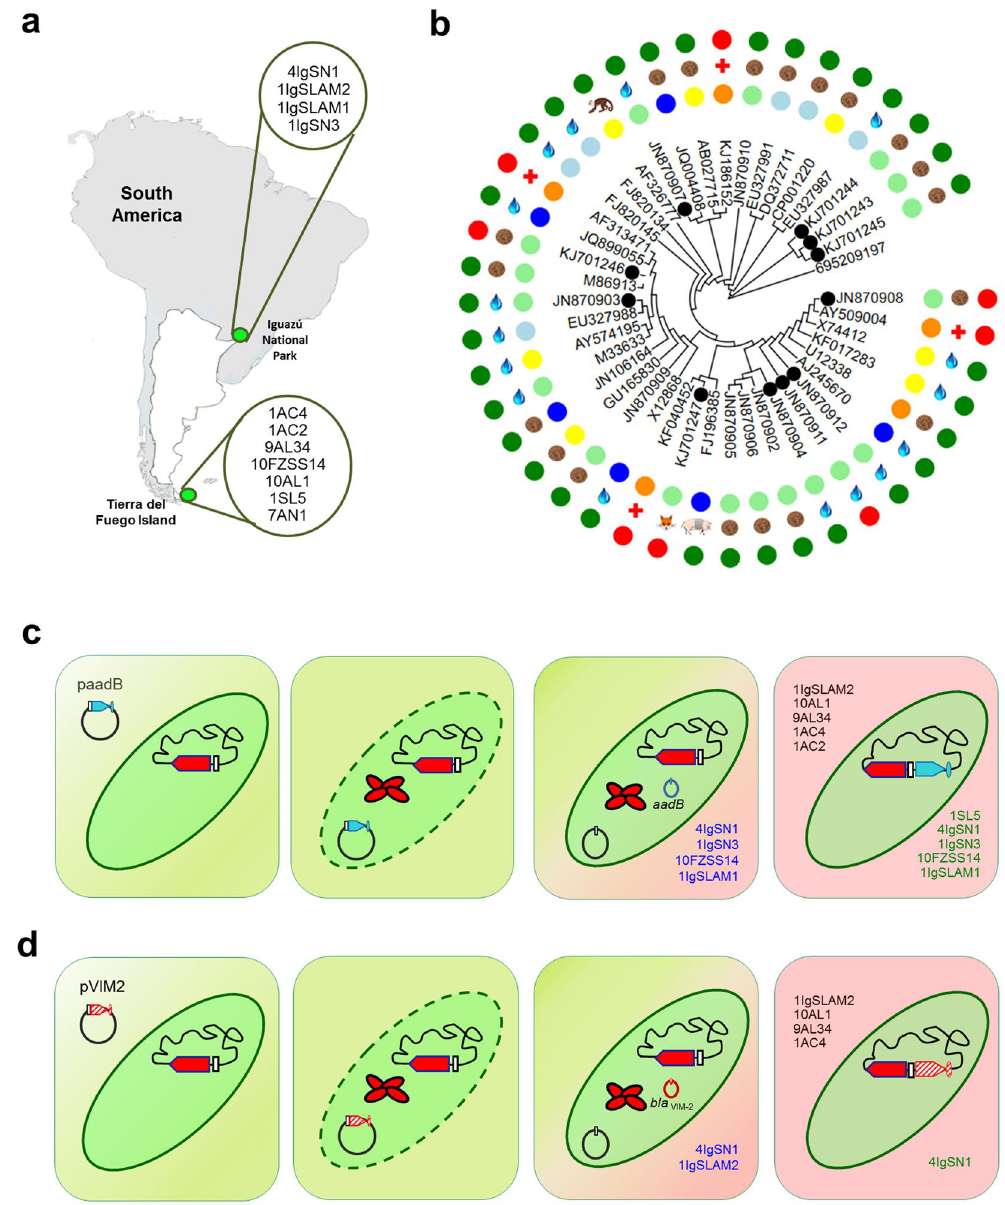
Figure 2. Model system of environmental intI1 -positive strains used for ARGC acquisition. ( a ) Origin of environmental strains. Escherichia coli 4IgSN1, Enterobacter sp. 1IgSLAM2, Acinetobacter sp. 1IgSLAM1 and Acinetobacter sp. 1IgSN3 were isolated in Iguazú National Park in Misiones Province, whereas, Pseudomonas sp. 1SL5, Enterobacter sp. 10AL1, Aranicola sp. 9AL34, Pseudomonas sp. 7AN1, Aeromonas media 1AC2, Vibrio sp. 1AC4 and Pantoea dispersa 10FZSS14 were obtained from Tierra del Fuego Island, Argentina. South America map was modified from public domain artwork (https://openclipart.org/detail/181050/argentina-location). ( b ) Phylogenetic tree of environmental intI1 alleles. A total of 36 alleles of the intI1 gene were identified from a BLASTn query using AF313471 as a reference (April 2015). Black dotted circles correspond to environmental strains used in this study. The inner lane corresponds to the provenance of the intI1 -positive strain: blue for Europe, yellow for Asia, light blue for Oceania, light green for America and orange for pandemic dissemination. The medium lane corresponds to the type of sample: water drop for water sample, brown circle for soil, monkey for monkey faeces sample, pig for pig faeces sample and fox for fox faeces sample. The outer lane corresponds to the clinical (red circle) or environmental (green circle) source of the strain. ( c and d ) Steps of ARGC acquisition without antibiotic selection. Environmental isolates were subjected to artificial and natural transformation with plasmids paadB ( c ), carrying the aadB gene cassette, and pVIM2 ( d ), carrying the bla VIM-2 gene cassette. After transformation, functional native IntI1 excised the ARGC and inserted it in the native attI1 site. Plasmid maintenance during 40 generations was observed in environmental strains that are in blue letters. Environmental strains able to perform ARGCs acquisition by both natural and artificial transformation are in green letters, while isolates that only insert the ARGC as a result of an artificial transformation are in black